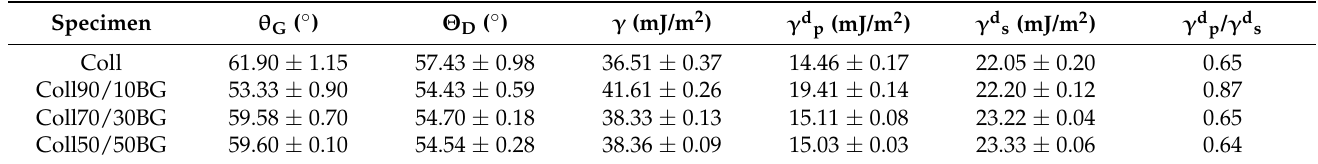
Table 3. Surface free energy ( γ ) and its polar ( γ d p ) and dispersive ( γ d s ) components for collagen materials modified with β -glucan.